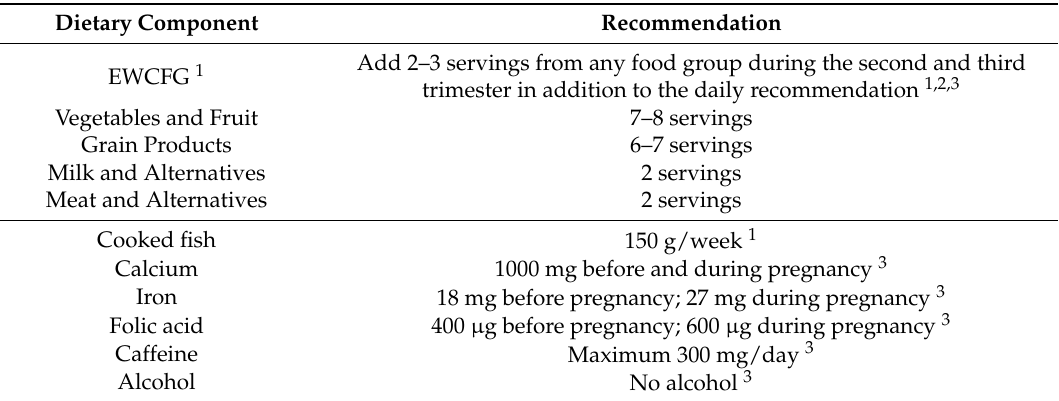
Table 1. Dietary recommendations for